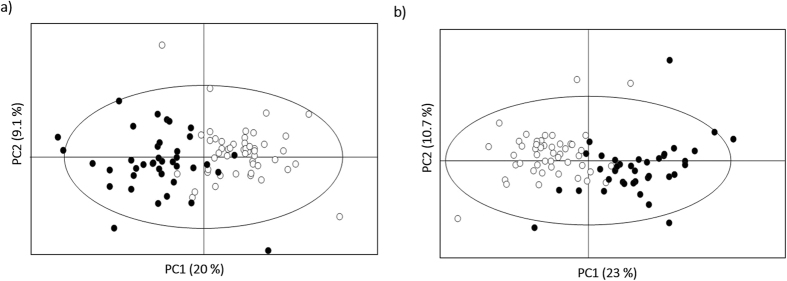
PCA scores scatter plots obtained for the NMR spectra of the urine of the unmatched cohort: n = 49 controls (○) vs. n = 39 RCC patients (●), (a) with the 32-resonance subset and (b) with the 23-metabolite signature, i.e. with bias resonances removed. All models were obtained with 2 principal components and the ellipses indicate the 95% confidence limits.